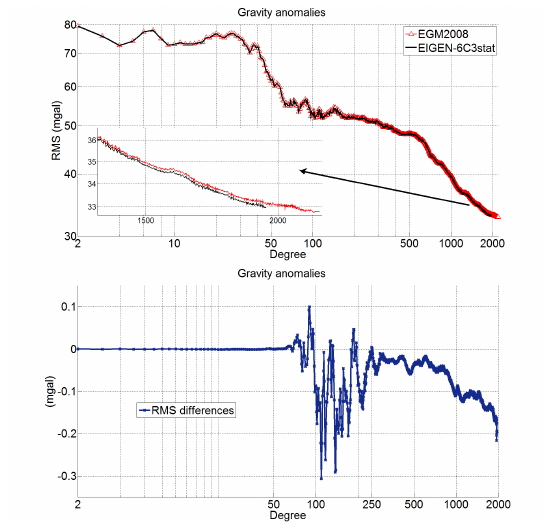
Figure 3: RMS variations in free-air gravity anomaly that have been obtained from comparison between terrestrial gravity data and com- puted values based on the EIGEN-6C3 and EGM2008 models. RMS differences (EIGEN-6C3 minus EGM2008) at the level of 10 −1 mgal are monitored over the degree 1000 while wide discrepancies are occurred in the degree bandwidth 70 to